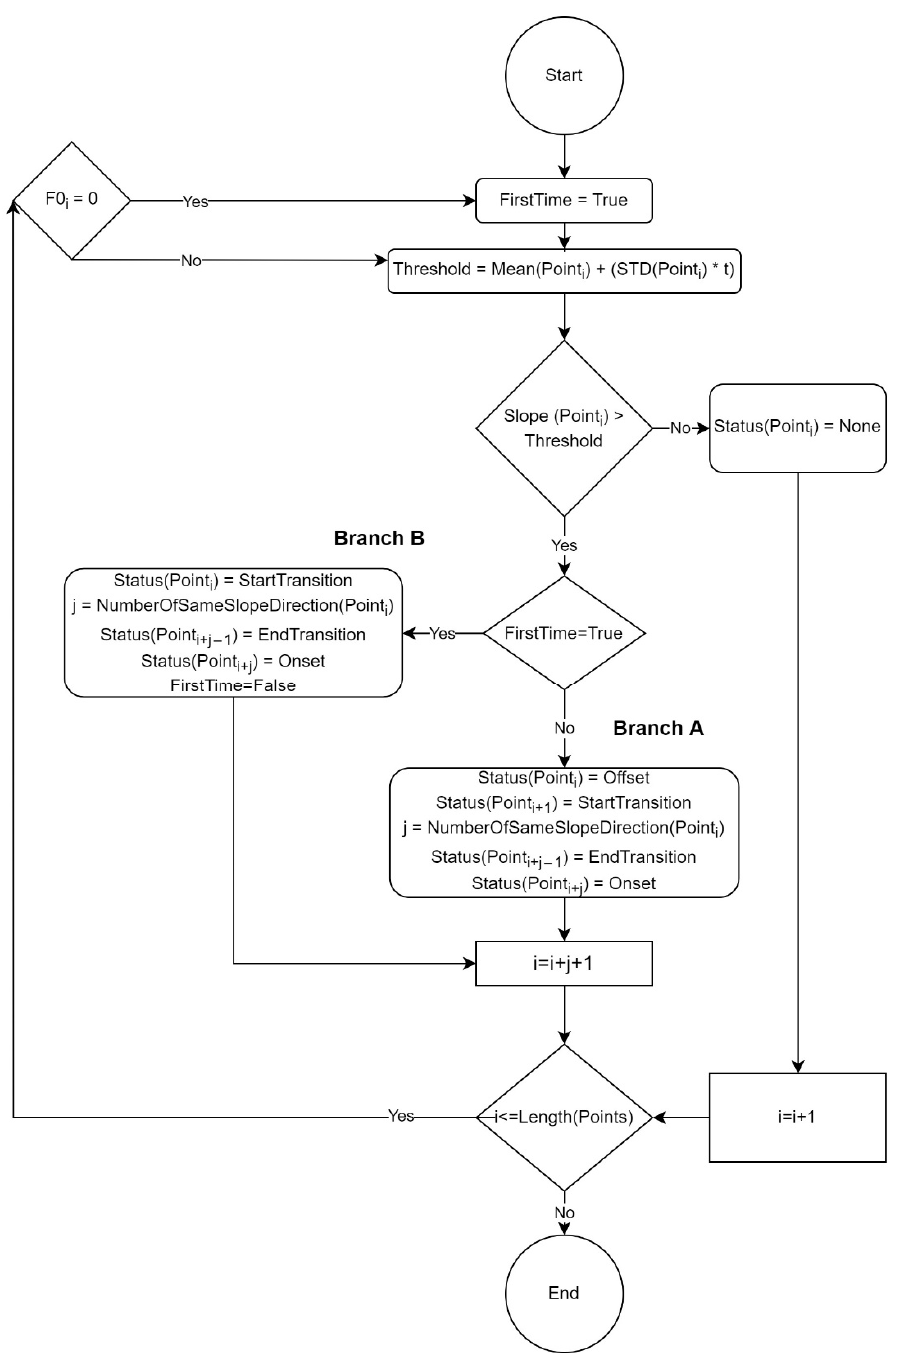
Figure 7. The algorithm for finding a significant change to find onset, offset, and